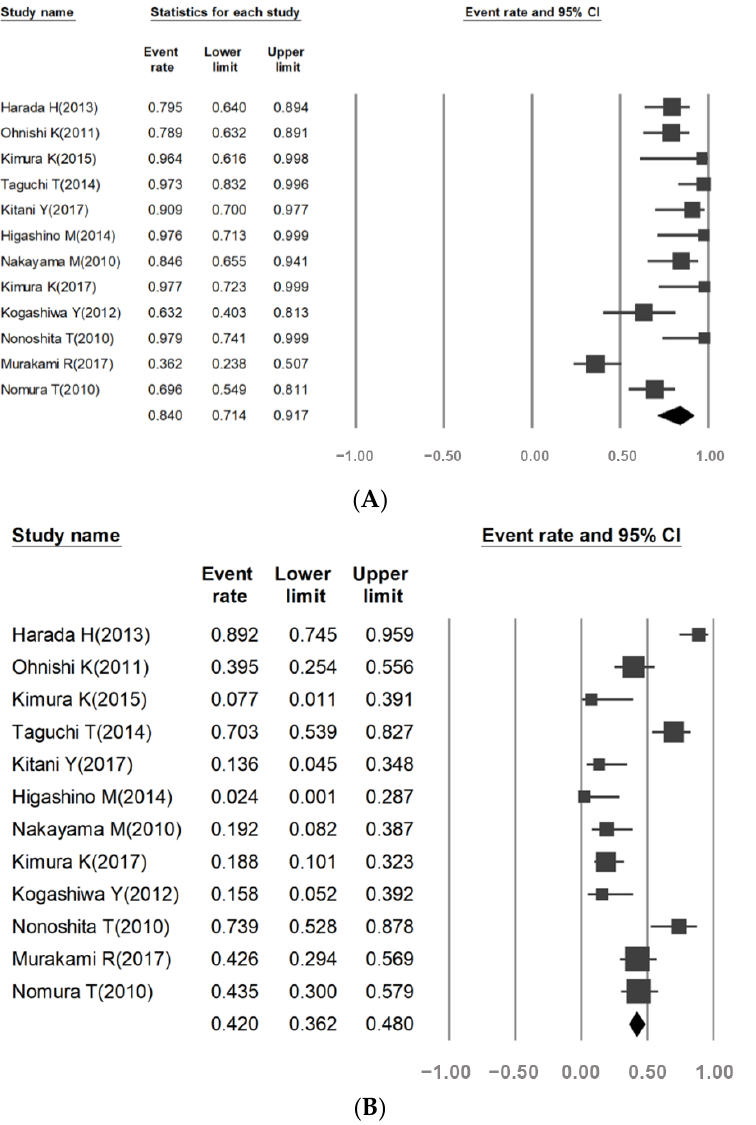
Figure 3. Three-year overall survival ( A ), grade 3/4 adverse events ( B ) of S-1 combined with chemoradiotherapy (CRT) for Non-nasopharyngeal head and neck cancer.